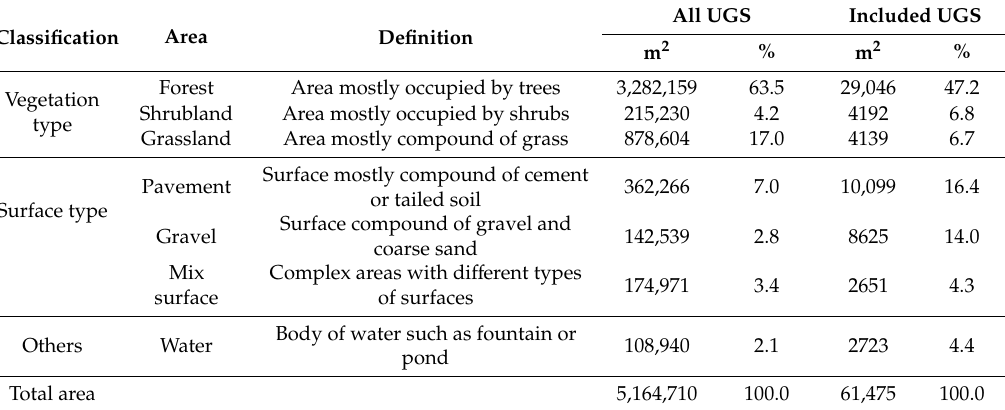
Figure 2. Example of the characterization of UGS by type of vegetation and walkable surface. Source: Own production based on ArcGIS © Online base map [51]. Table 1. Characteristics of the analyzed Urban Green Spaces.